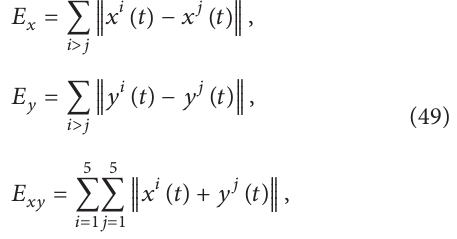
Figure 2: (a) The synchronization error evolution of the driver networks 𝐸 𝑥 (𝑡) ; (b) The synchronization error evolution of the response networks 𝐸 𝑦 (𝑡) ; (c) The anti-synchronization error evolu- tion between the driver networks and the response networks 𝐸 𝑥𝑦 (𝑡) with the pinning